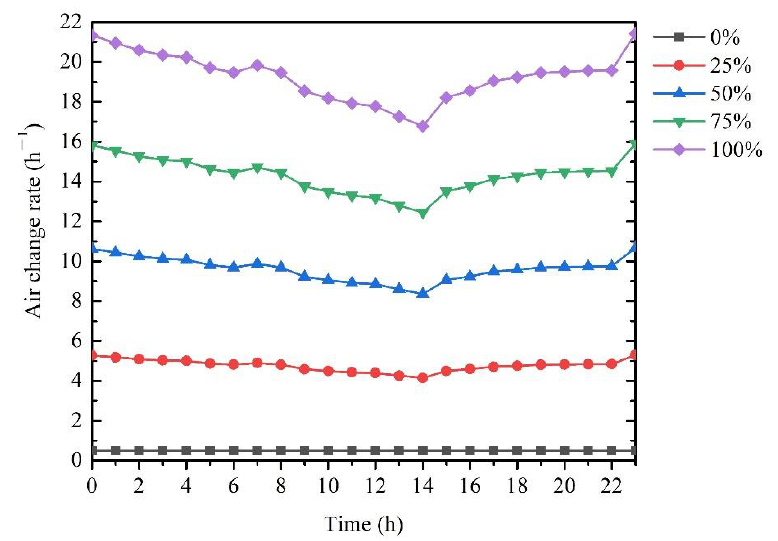
Figure 5. Relationship between the air change rate and window opening degree during the natural ventilation scenario.